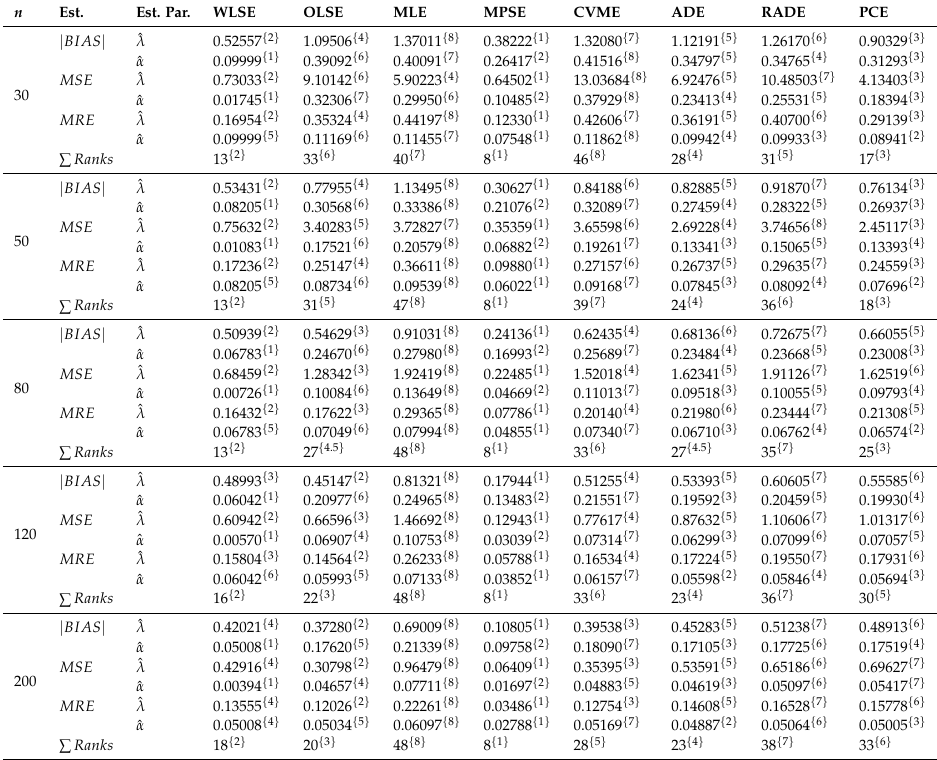
Table 9. Simulation results for φφφ = ( λ = 3.1, α = 3.5 ) (cid:124)